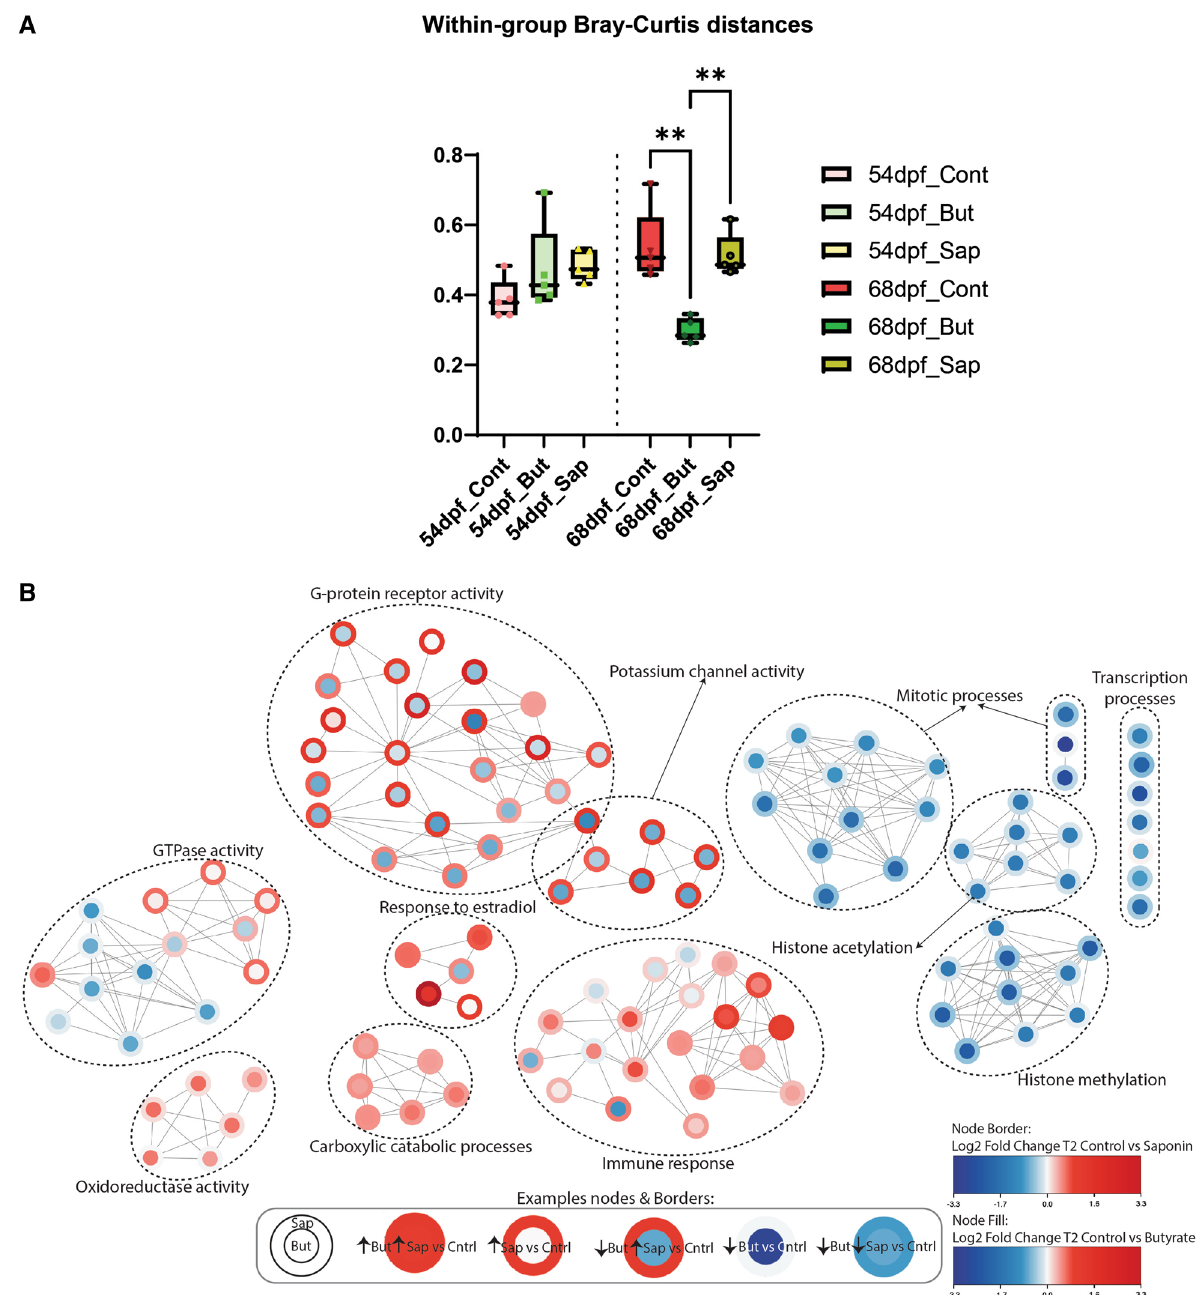
Fig. 6 Effects of butyrate and saponin on the host gut transcriptome. A Bray–Curtis distances to examine the dissimilarity of the host transcriptome across diets and timepoints. ** p 0.01, Kruskal–Wallis test after testing for non-normally distributed data by Shapiro–Wilk test. Whiskers: min. to ≤ max. shall all points with median. B Network depicting transcriptomic regulation of butyrate and saponin supplemented diets vs control diet at 68 dpf. Each node is a GO term and the node border represent the log2 fold-change of the control diet vs the saponin supplemented diet and the node fill represent the log2 fold-change of the control diet vs the butyrate supplemented diet. The edges connect nodes containing at least 10 genes and sharing 50% of the contained genes. Related GO terms are encircled encompassing canonical pathways. Shared effects on the gut transcriptome can be observed when edge and fill of a node have the same color in the network: up-regulation -in red- and down-regulation -in blue- compared to the control feed. C Immune response-associated GO terms and particularly inflammatory response analysed in fish fed a control, butyrate and saponin diet. Genes are expressed in tpm and scaled colored per individual gene value. The heatmap contained genes color-scaled per individual gene that reflect the individual within group fish-to-fish